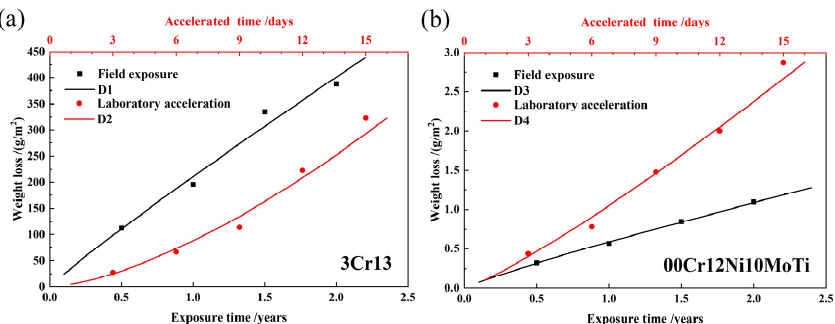
Figure 3. Field exposure and laboratory-accelerated corrosion weight loss of two materials with time and their fitting curves: ( a ) 3Cr13, ( b ) 00Cr12Ni10MoTi. Table 6. Corrosion kinetic equations of two stainless steels.